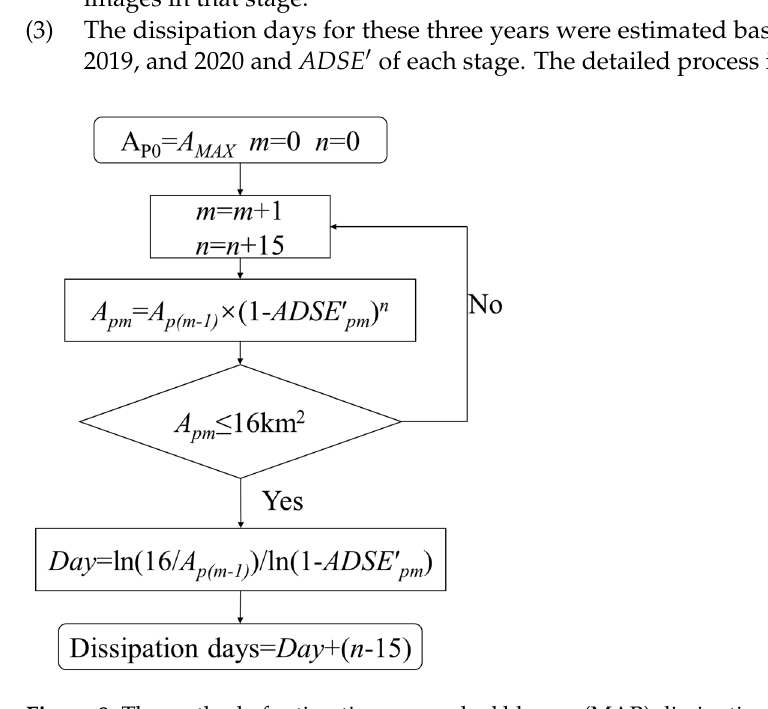
Figure 8. The method of estimating macroalgal blooms (MAB) dissipation days. m is the P m stage, and n is the nth day after A MAX . A MAX is the maximum of the daily coverage area of MABs. A pm is the macroalgae daily coverage area on the last day of the P m stage. ADSE (cid:48) pm is the ADSE (cid:48) of the P m stage. Day is the days taken from A p(m − 1) to 16 km 2